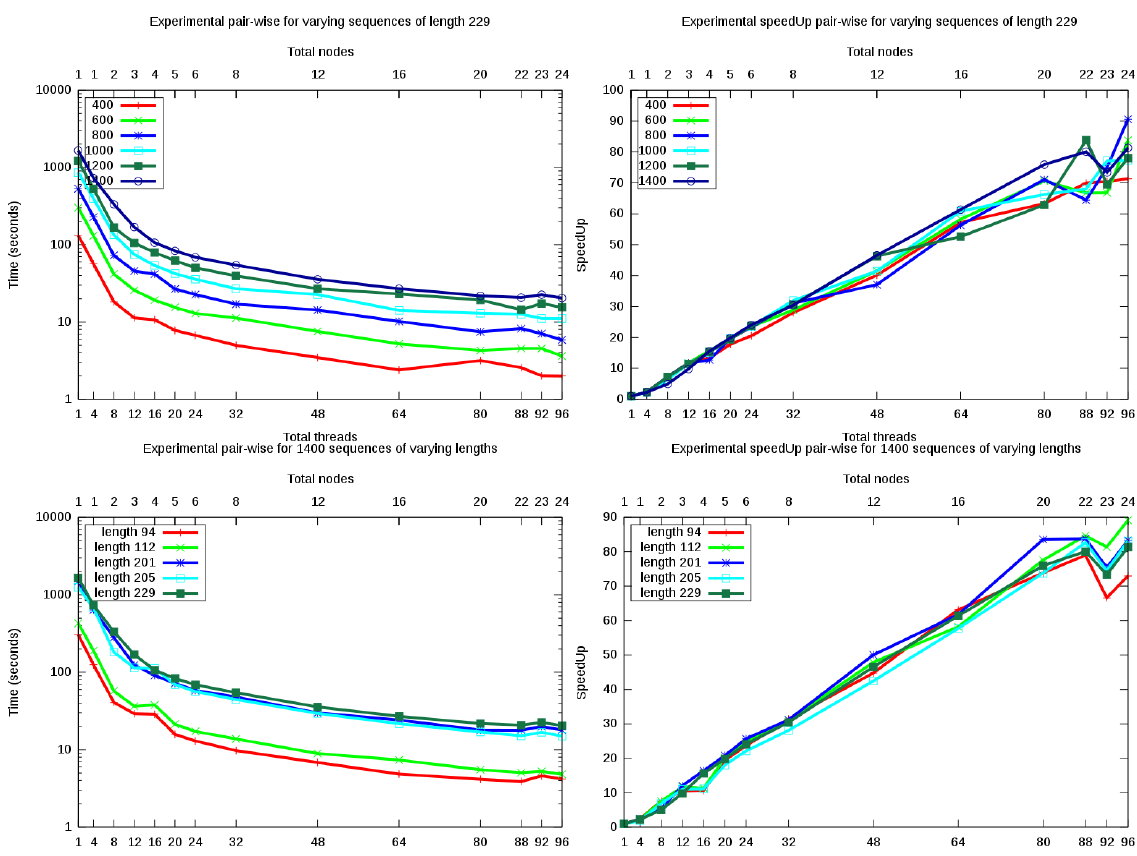
Figure 6: Pairwise time and SpeedUp varying the number of sequences and the sequence lengths.